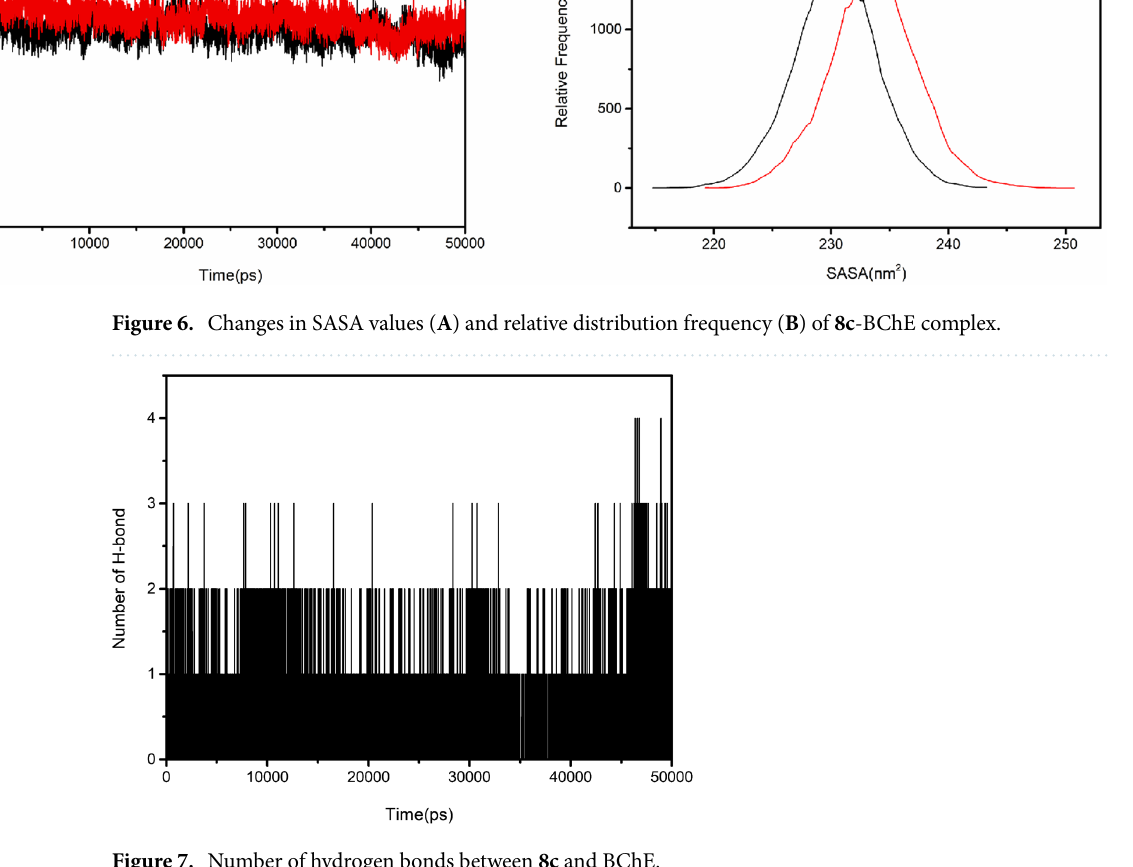
Figure 7. Number of hydrogen bonds between 8c and